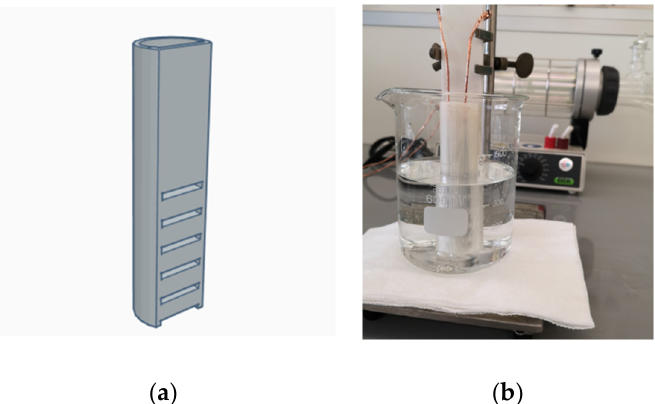
Figure 8. ( a ) Three-dimensional design of the sub-environment container; ( b ) measurement setup of capacitive water sensing.